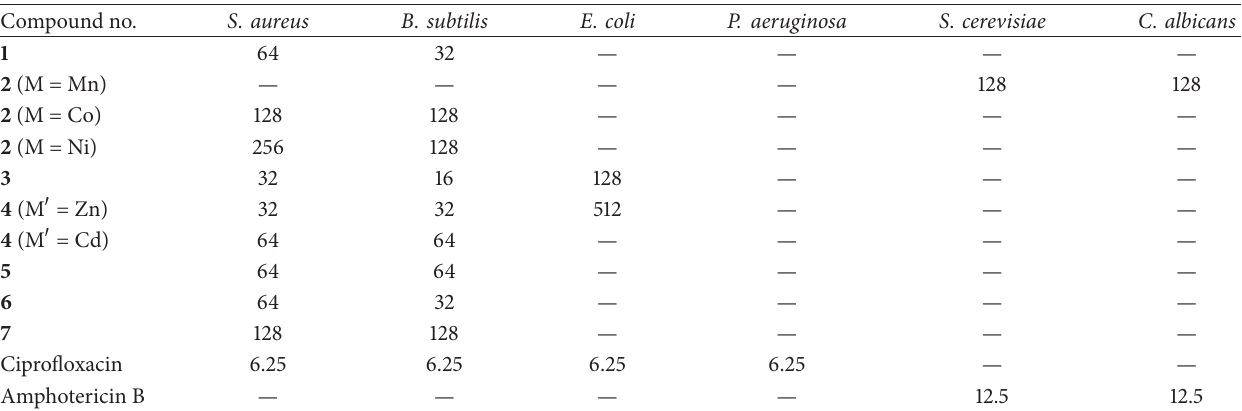
Table 5: Minimum inhibitory concentration (MIC) ( 𝜇 g/mL) of compounds by using modified agar well diffusion method. Compound